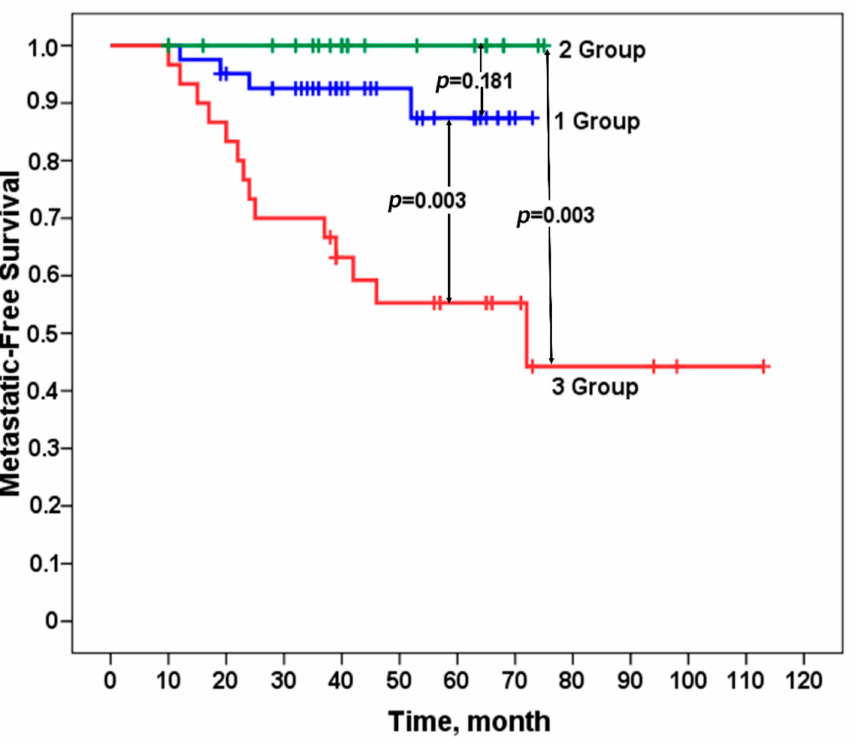
Figure 2. Metastasis-free survival in patients in groups 1–3 in the prospective study. p -value—log- rank